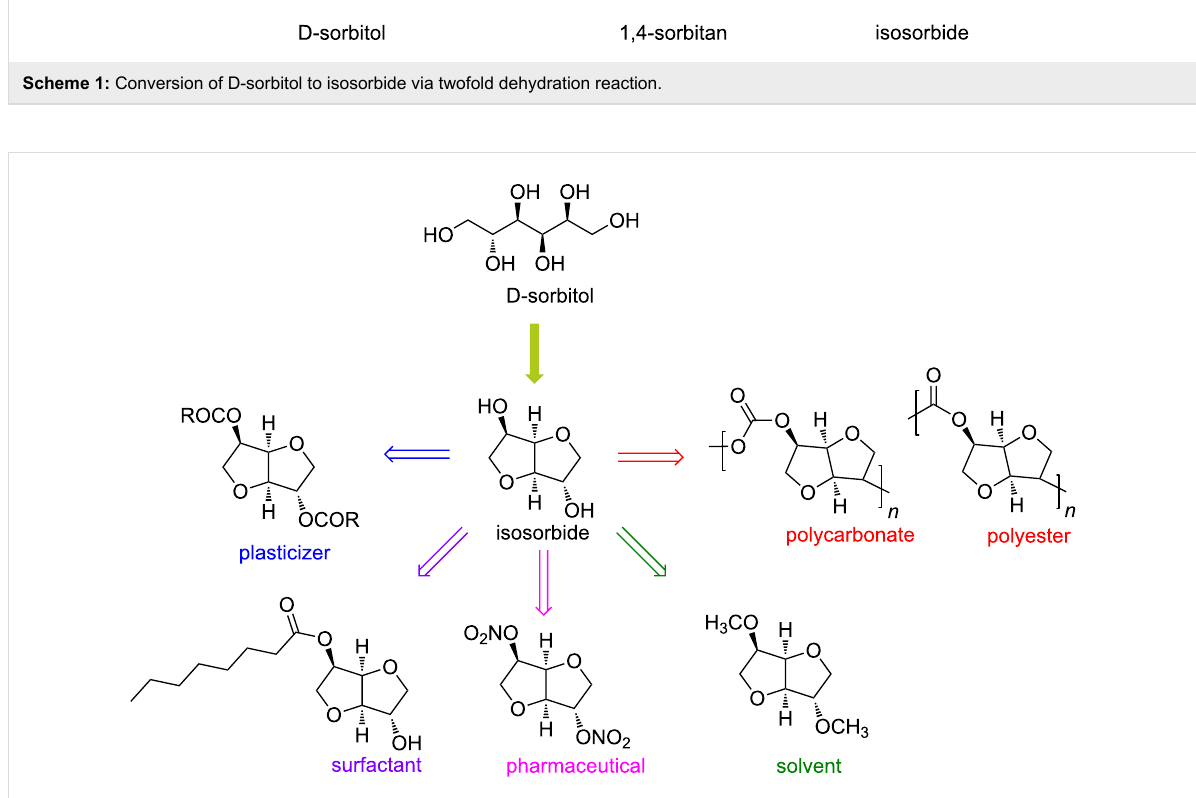
Figure 2: Chemical structure of isosorbide and its epimers isomannide and